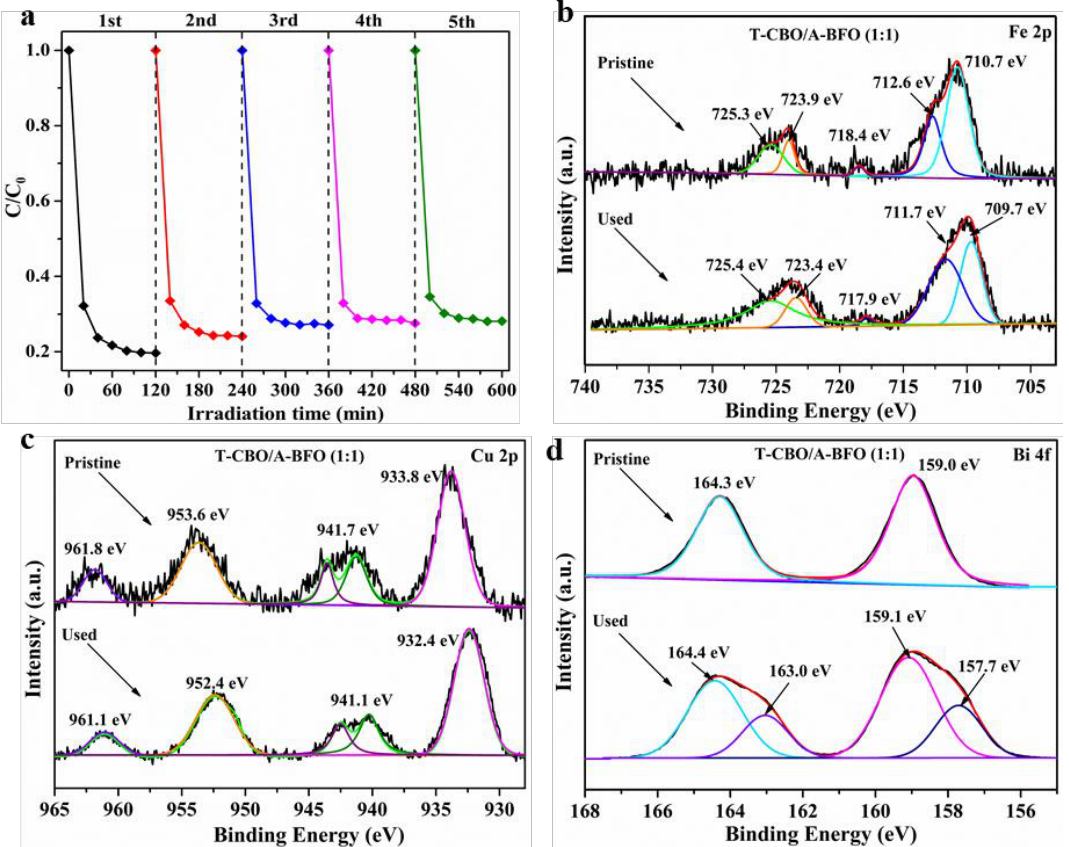
Figure 9. ( a ) Five-cycle test of T-CBO/A-BFO (1:1) composite photocatalyst for the degradation of methyl orange; ( b ) Fe 2p, ( c ) Cu 2p, and ( d ) Bi 4f XPS spectra of the T-CBO/A-BFO (1:1) composite before and after the stability test. The arrows pointed to the curves of pristine and used samples and specific XPS peaks in case of overlapping.